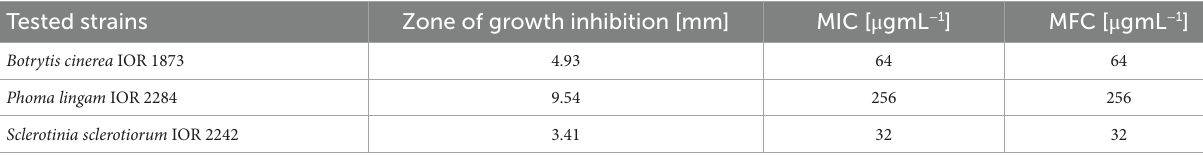
TABLE 4 Antifungal activity of AgNPs form Fusarium culmorum strain JTW1 against plant pathogens. Tested